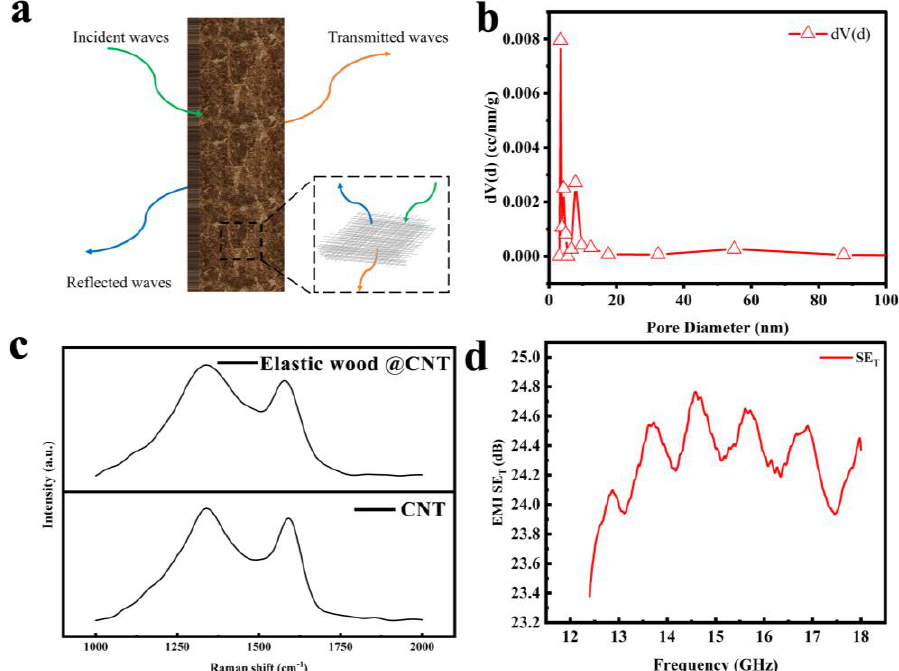
Figure 5. ( a ) The electromagnetic shielding mechanism diagram. ( b ) Distribution of pores in elastic wood. ( c ) Raman spectra of MWCNT-embedded elastic wood. ( d ) The electromagnetic shielding effectiveness of the material.